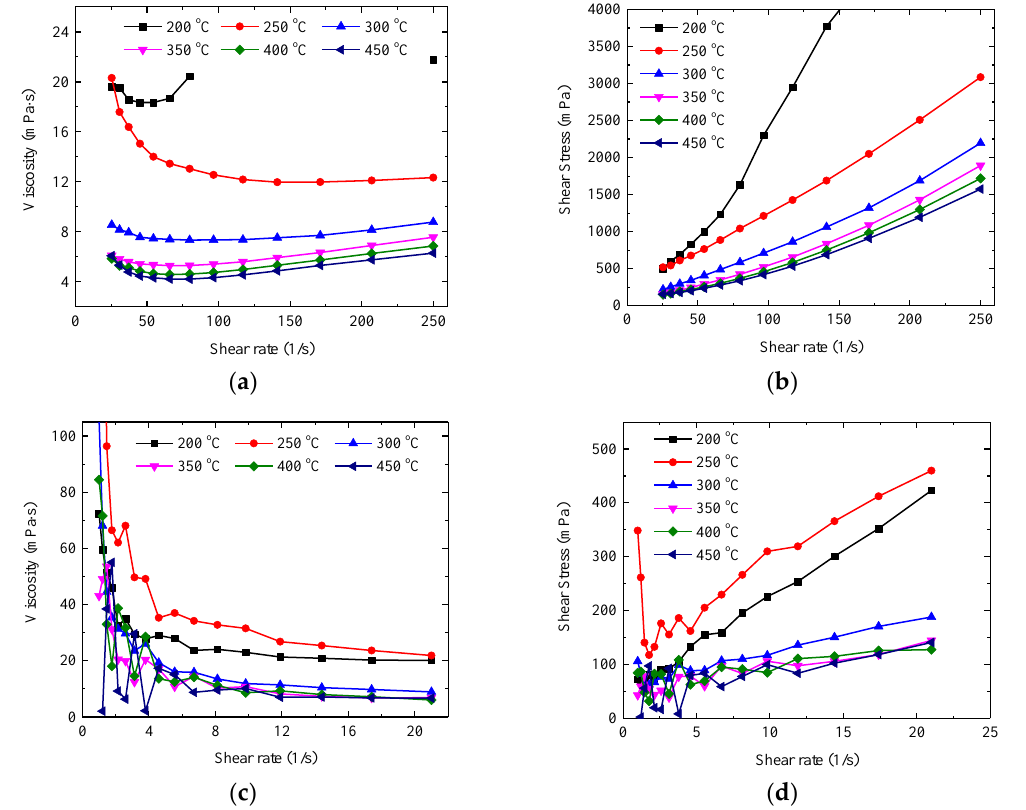
Figure 4. Viscosities and shear stresses against different shear rates for HITEC salt. ( a ) viscosity (25 s − 1 to 100 s − 1 ), ( b ) shear stress (25 s − 1 to 100 s − 1 ), ( c ) viscosity (1 s − 1 to 25 s − 1 ), ( d ) shear stress (1 s − 1 to 25 s − 1 ).